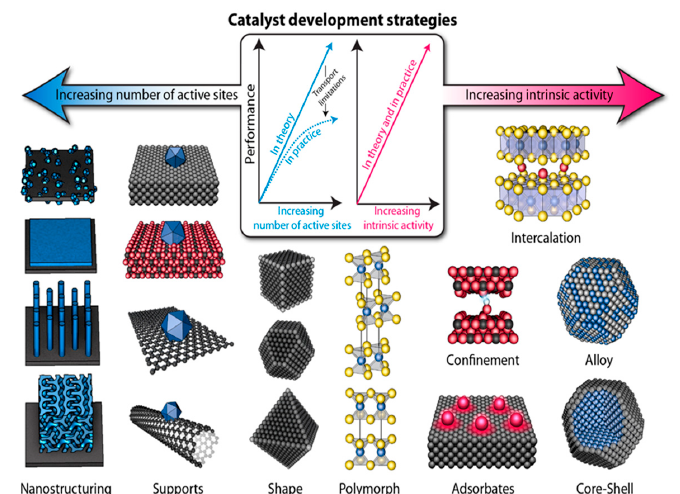
Figure 7. Schematic representation of various catalyst development strategies, which aim to increase the number of active sites and/or increase the intrinsic activity of each site. Reproduced from [86], with permission from the American Association for the Advancement of Science, 2017.